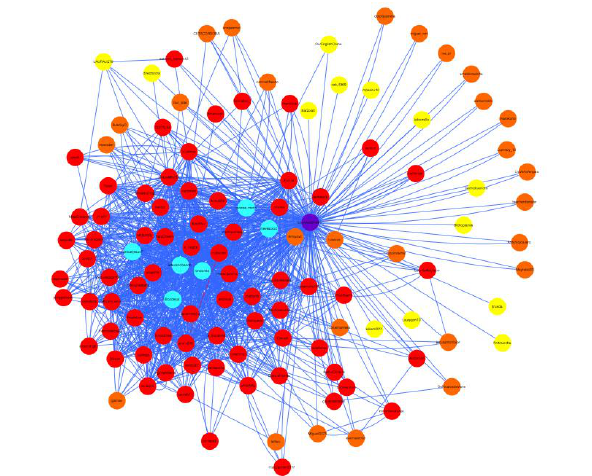
Figure 5 . Representation of the Books relations network topology.